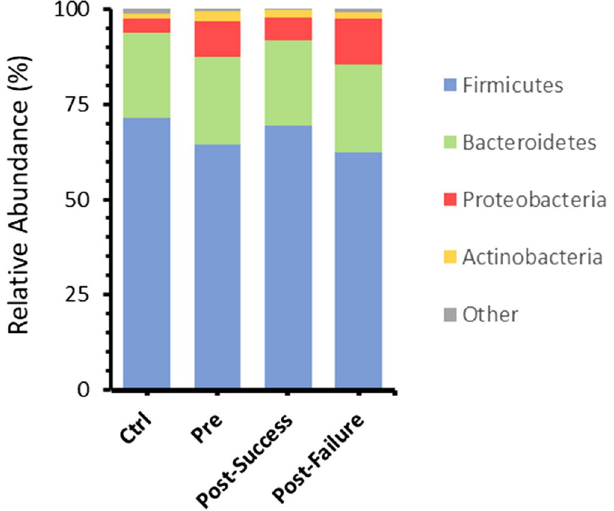
Figure 2. Bar charts showing mean values of ASV abundances at the phylum level in the four different groups studied: healthy individuals (control), Crohn’s disease patients pre-treatment (t0) and patients post- treatment (t1; in turn, classified into responders and non-responders). . “Other” refers to all phyla with an initial representation less than 2% of abundaces, including Euryarchaeota, Actinobacteria, Cyanobacteria,